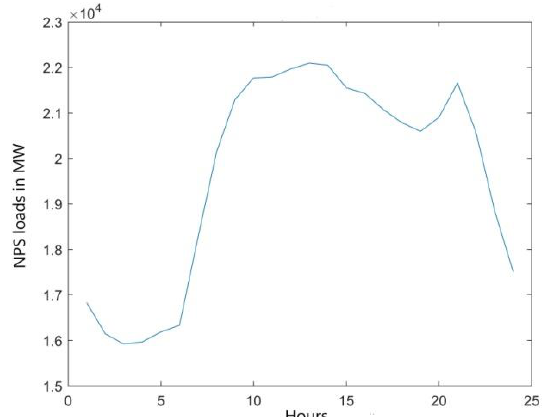
Figure 1. Daily load variability for National Power System(NPS) in Poland on 21 August 2019 (Source: own work based on PSE-Operator S.A. (Source: own work based on PSE-Operator S.A. http://www.pse-operator.pl).